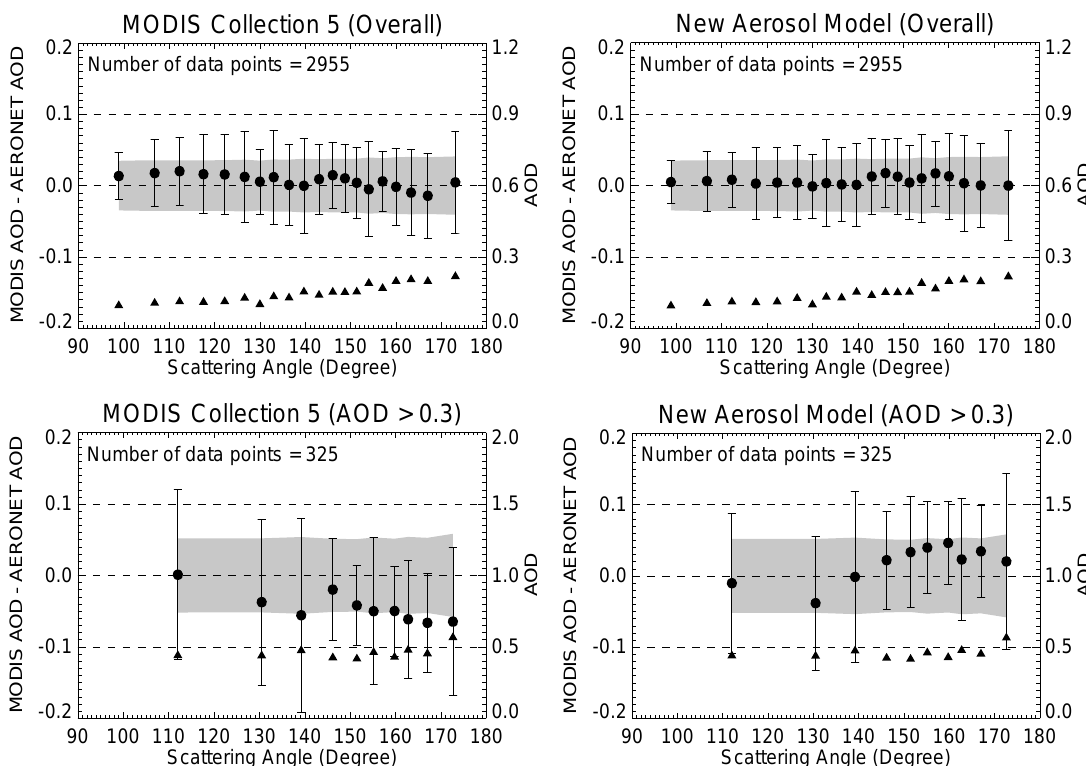
Fig. 8. Scattering angle dependence of retrieval errors for the C005 algorithm (left) and the test algorithm (right) for overall data (upper) and data for AOD > 0.3